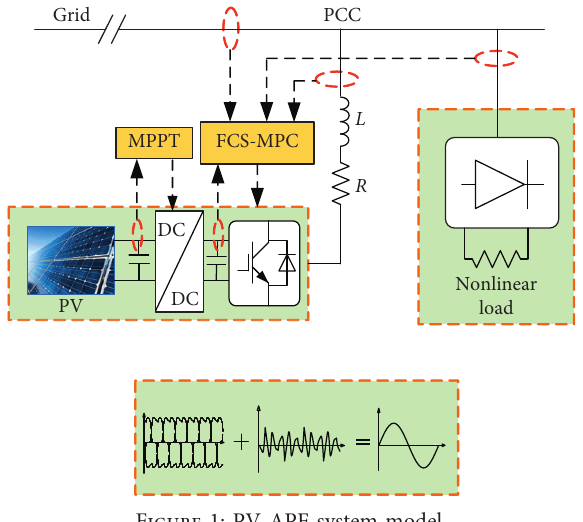
Figure 1: PV-APF system